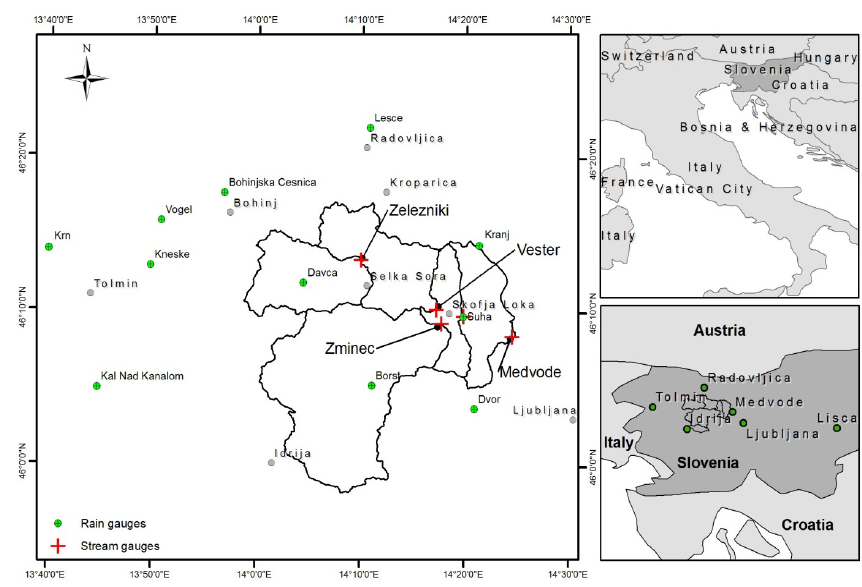
Figure 1: Case study area divided in five subbasins. Crosses represent the available stream gauges, while cross dots correspond to raingauges used in the present study. Gray dots represent other areas of interest.